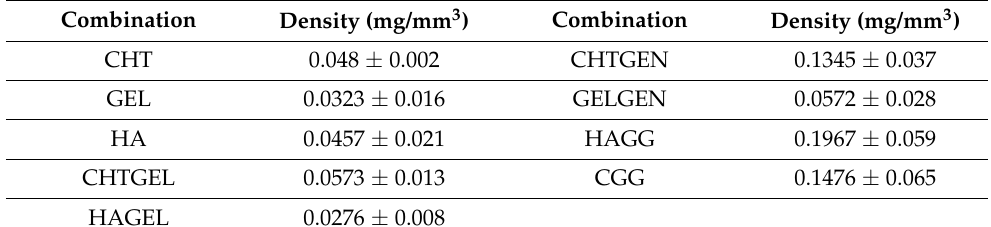
Table 3. Density of the pristine polymers and their crosslinked scaffolds (n =